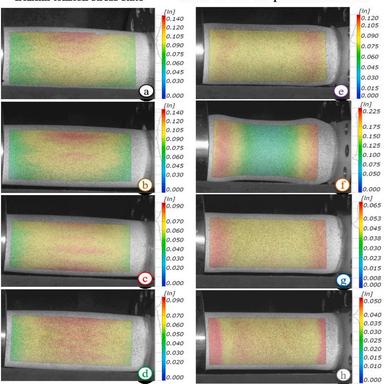
Mises strain distribution measured by the 3D DIC system for the tube bulging experiments performed for eight different biaxial deformation modes.